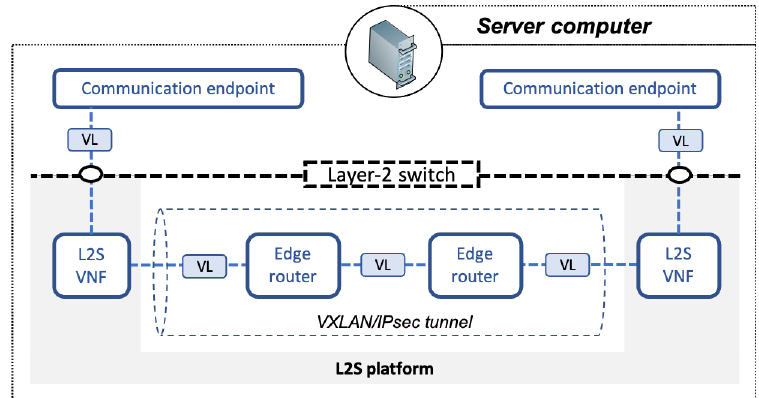
Figure 4. Performance evaluation scenario.